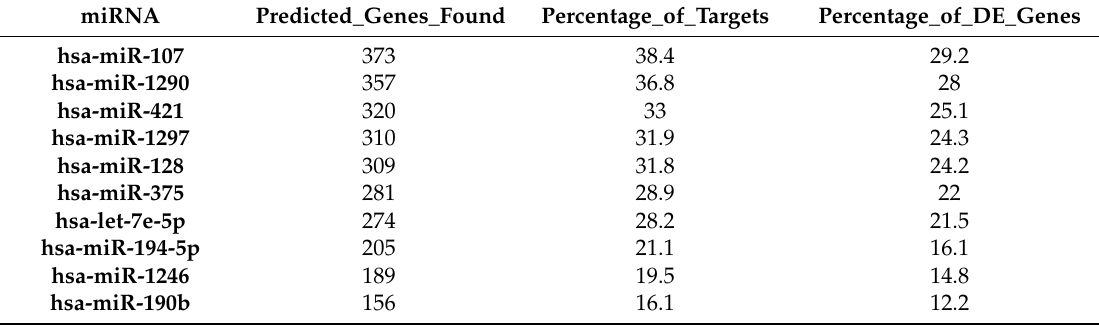
Table 5. miRNA impact on the gene expression; upregulated miRNA affecting downregulated genes.